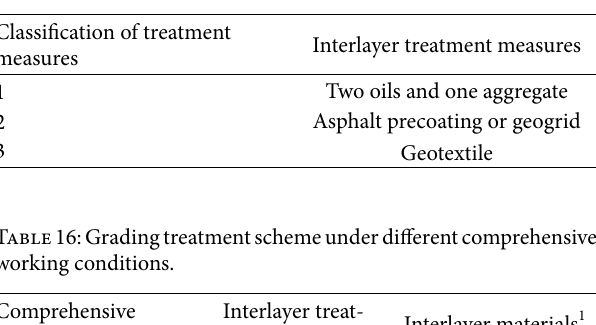
Table 15: Single performance classification of interlayer treatment scheme.